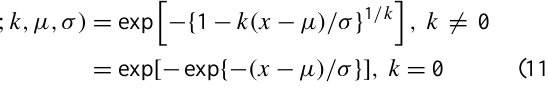
R high >D high R low >D